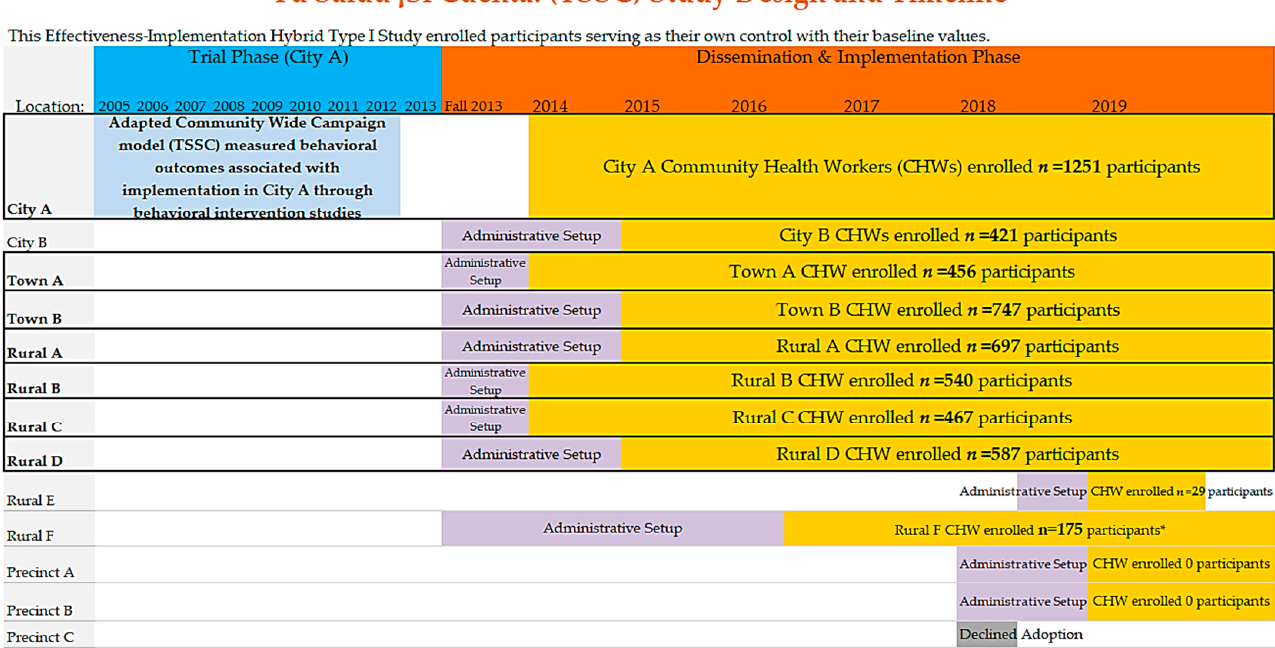
Figure 3. TSSC Dissemination and Implementation Timeline. Sample size only represents participants at each site that completed a minimum of 2 community health worker (CHW) home visits by study conclusion (11/2019). The width of colored bars in each row indicate the length of time the TSSC intervention was implemented at a location. Bolded sites with thick borders indicate a sufficient sample size ( n ≥ 35) in the “High Dose Exposure” group ( ≥ 4 CHW Home Visits) for our location ‐ specific analysis. The administrative setup indicates that the site agreed to adopt TSSC, contractual agreements were finalized, administrative arrangements were provided, and personnel were brought onboard.